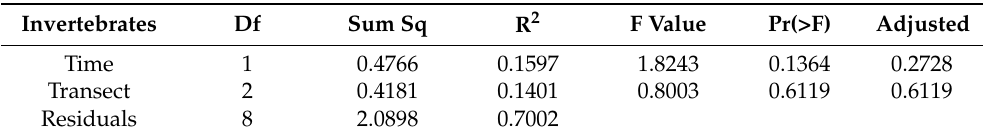
Table 5. PERMANOVA (permutational multivariate analysis of variance).testing for a difference in the biodiversity of macroinvertebrates at the Coral Greenhouse across time. A million permutations were used with the transect as a blocking factor. p -values were adjusted to account for repeated cases using Benjamini and Hochberg method (1995).